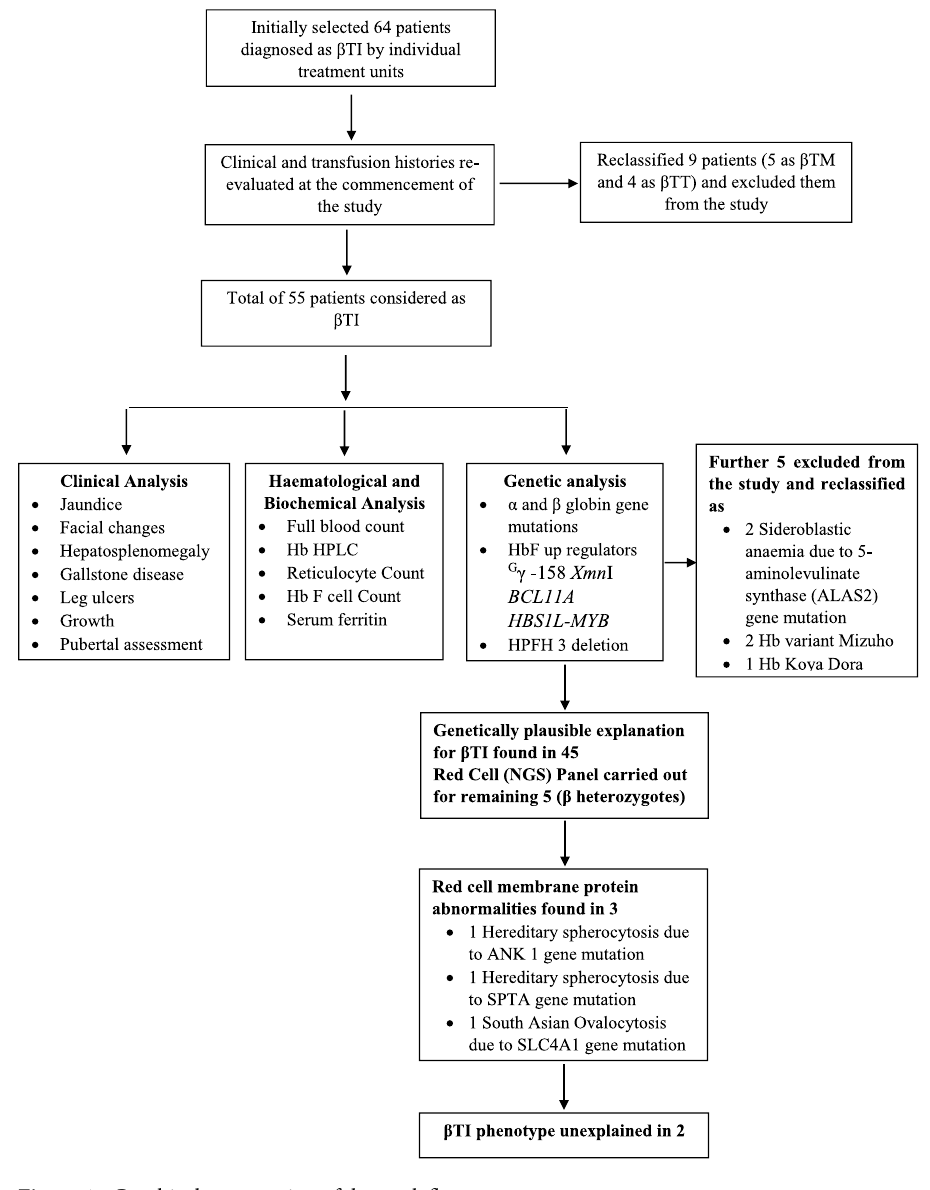
Figure 1. Graphical presentation of the work